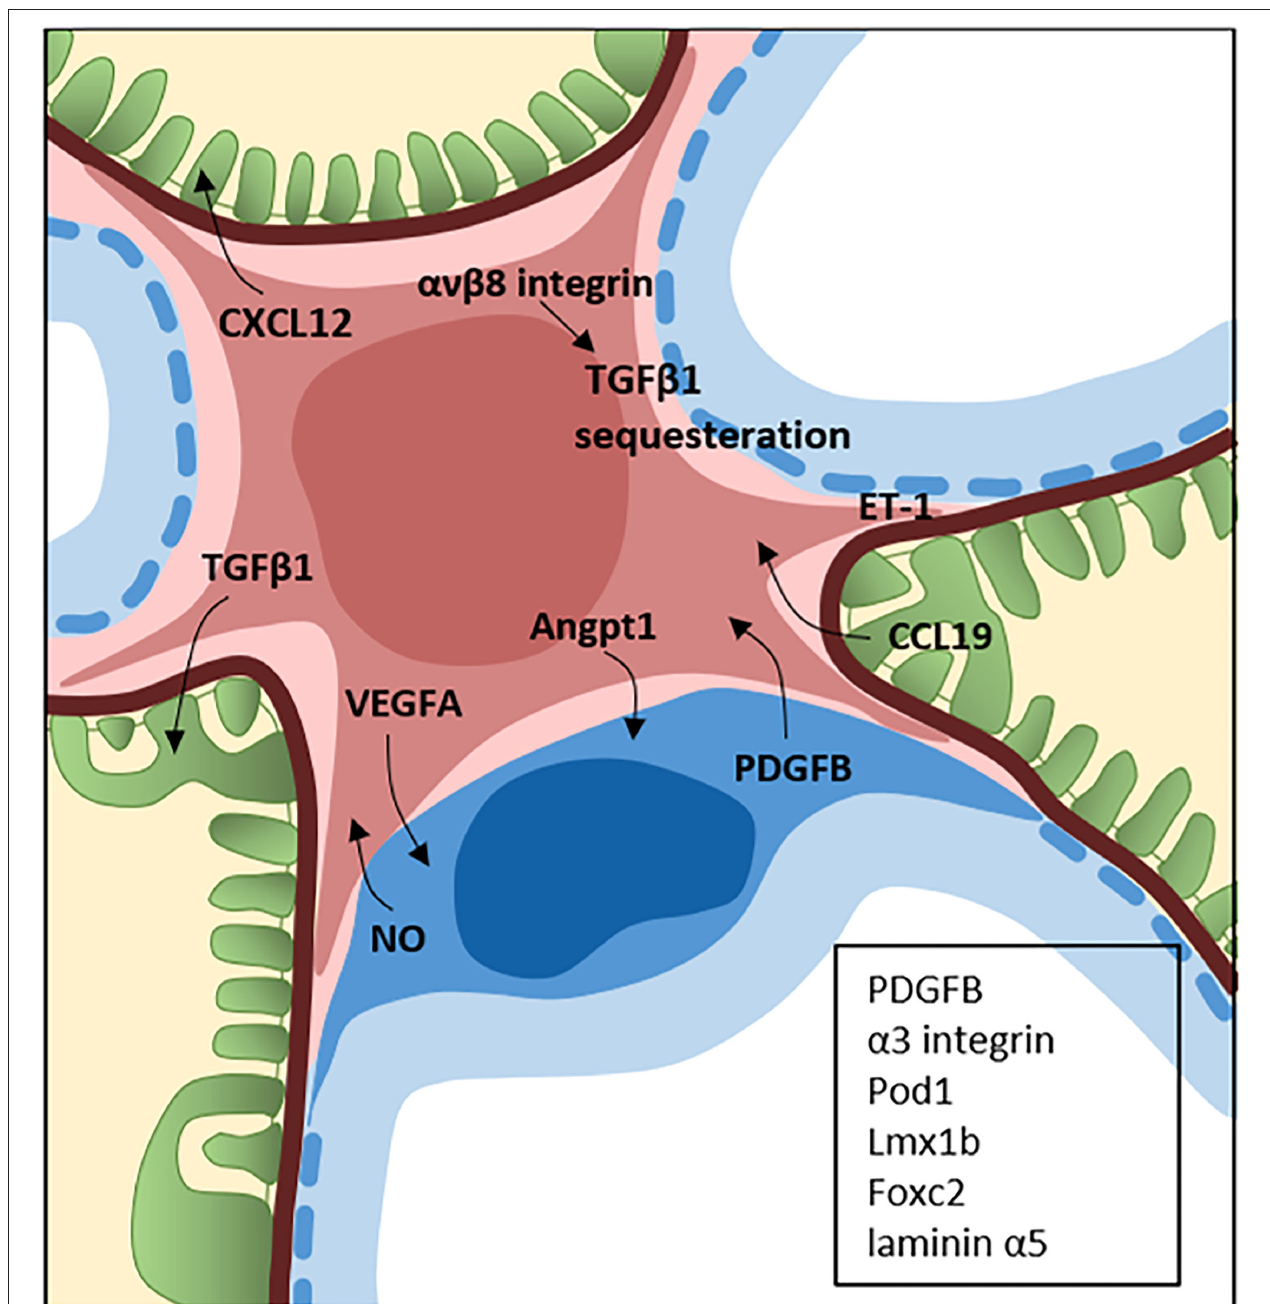
FIGURE 1 | Crosstalk between the mesangial cells, podocytes and glomerular endothelial cells. The central position of mesangial cells (pink) in the glomerulus is a perfect location for crosstalk with both the podocytes (green) and endothelial cells (blue). The field of glomerular crosstalk is emerging and the figure summarizes some of the known crosstalk signaling molecules between mesangial cells and the podocytes and endothelial cells in the normal and diseased state. Endothelin-1 (ET-1) is expressed by all glomerular cells and the crosstalk can occur in several directions. The proteins in the black box represents proteins expressed by the endothelial cells (PDGFB) and podocytes (PDGF, α 3 integrin, Pod1, Lmx1b, Foxc2, and laminin α 5) which are known to be necessary for normal development of the mesangium.